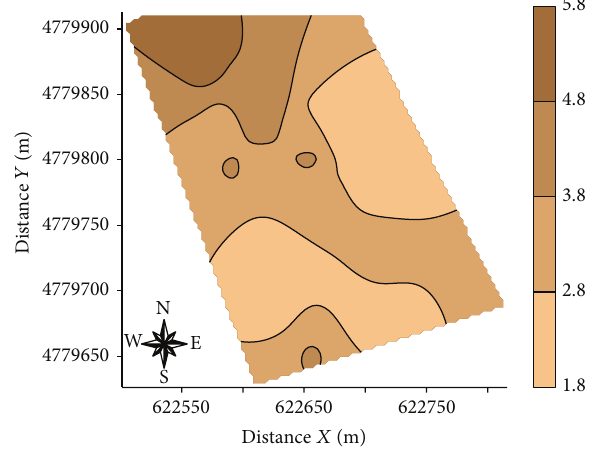
Figure 5: Map of EC